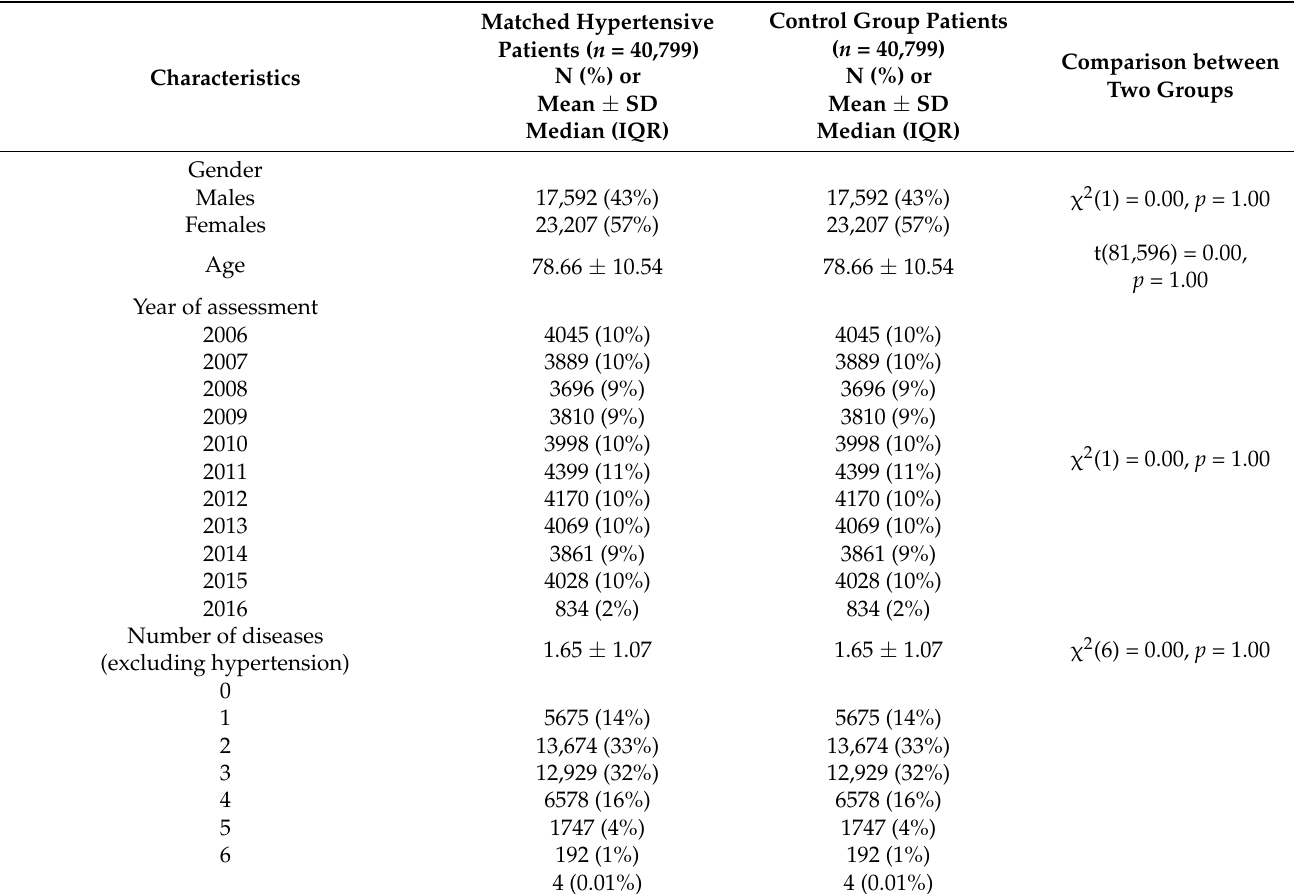
Table 1. Descriptive characteristics of matched